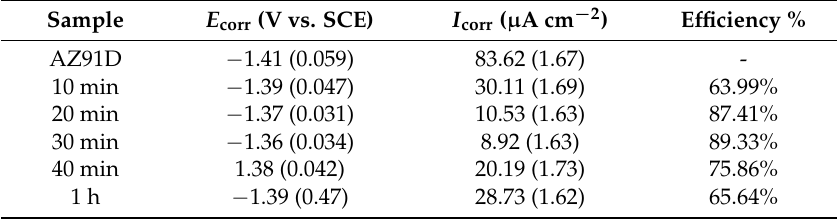
Table 3. Electrochemical parameters of the LDHs conversion coatings at different times.